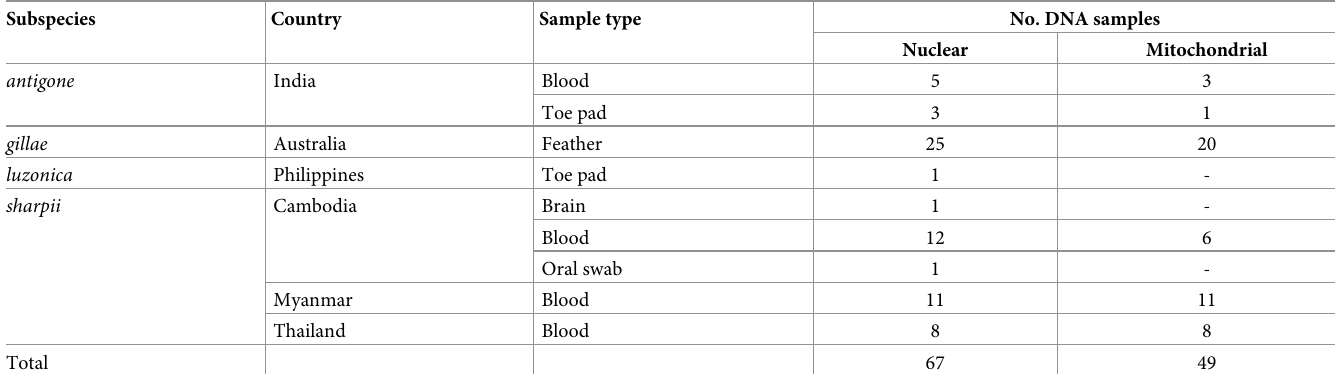
Table 1. Sources of Sarus Crane DNA used in analyses.